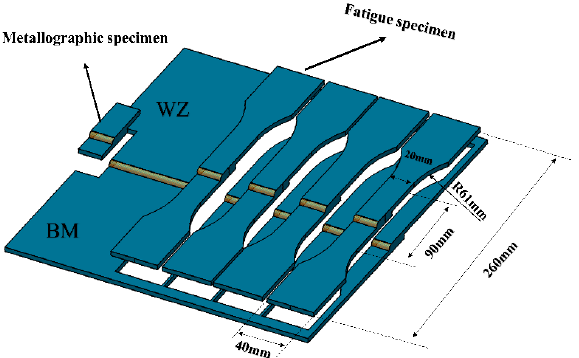
Figure 2. Fatigue test specimens, schematic of the weld joint, and metallographic